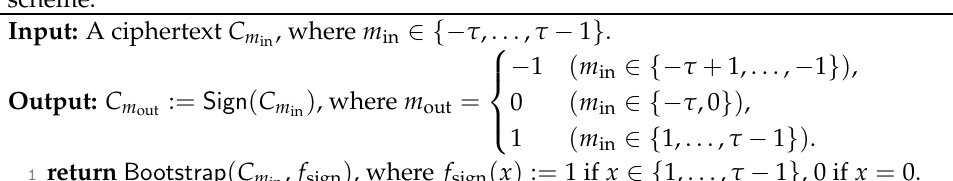
) : Equality test. , C m 2 1